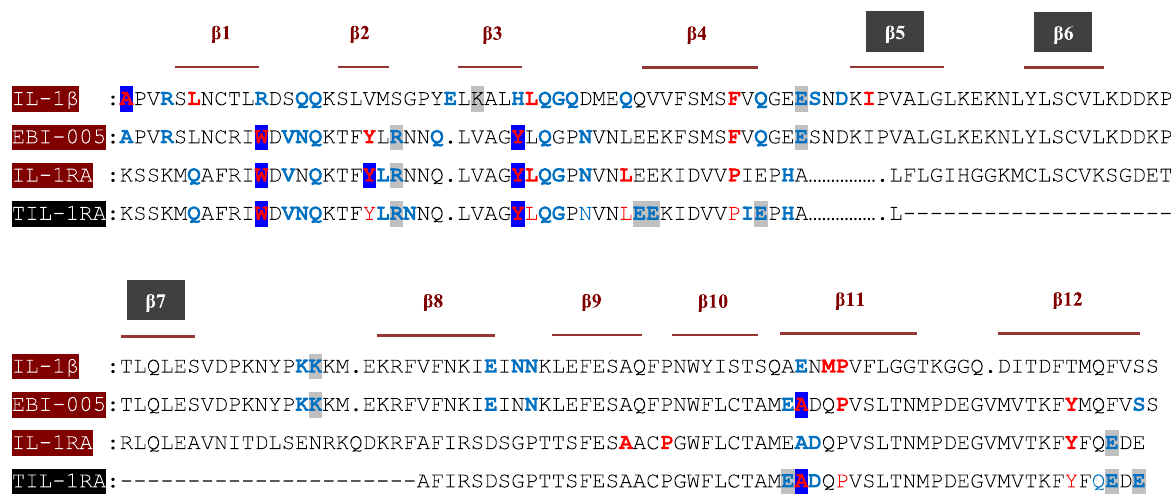
Figure 1. Identification and characterization of a novel truncated IL-1RA that shares homology with IL-1β and EBI-005. Sequence alignment of ligands with colorful residues implicated in interaction with IL-1R1, identified by ZDOCK within 4 Å. Hydrophobic interaction: red, Hydrogen bond: blue and Ionic interaction: